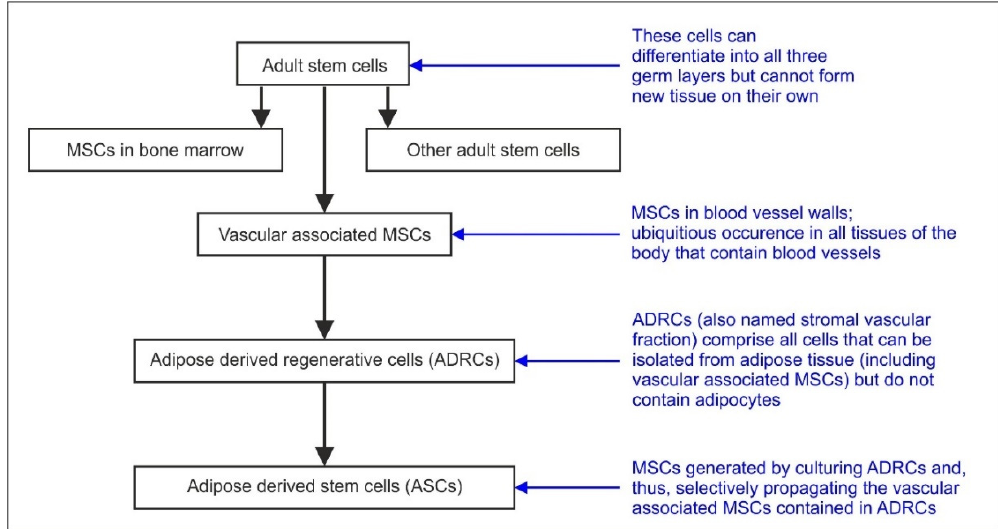
Figure 3. Schematic overview of the relationship between the term adult stem cells, vascular associated MSCs, ADRCs and ASCs (modified from [3]).